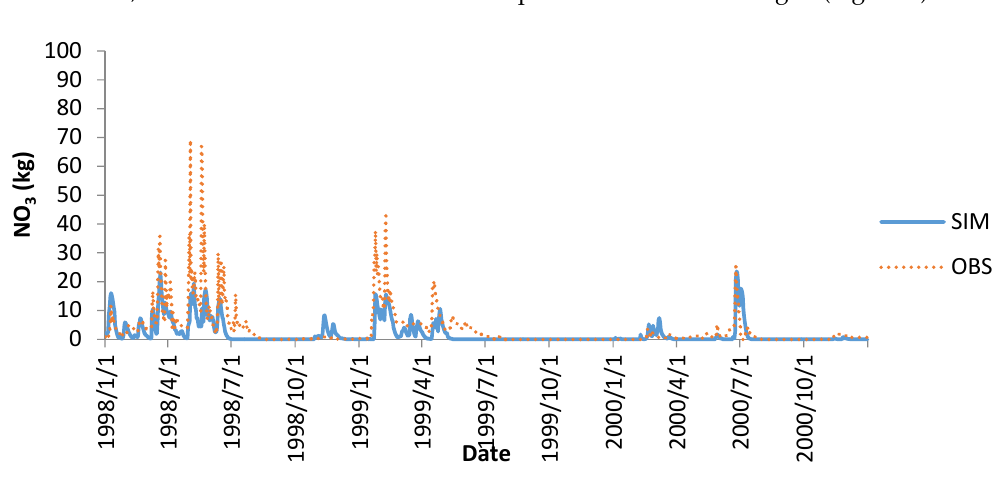
Figure 3. Comparison of daily observed and simulated nitrate discharge at watershed outlet (1998–2000).